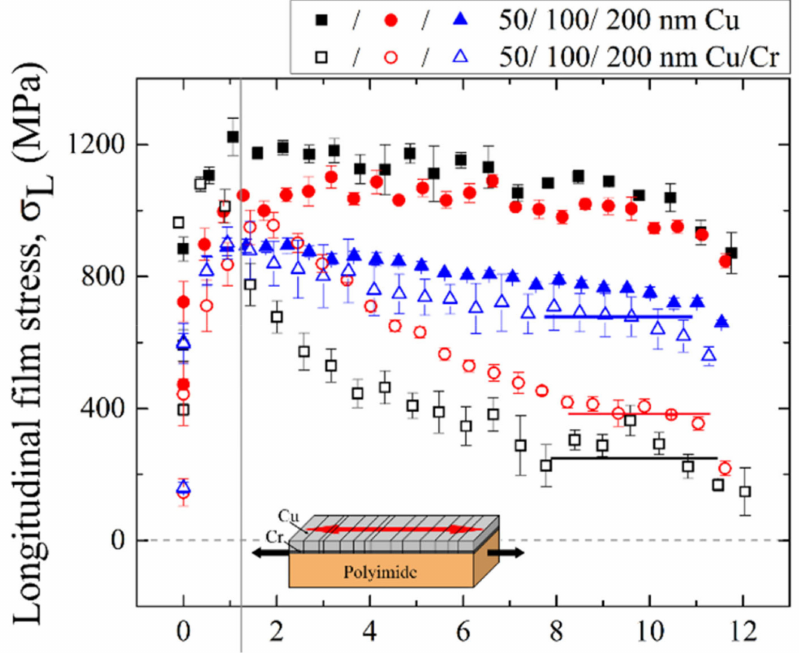
Figure 9. In-situ XRD stress measurements during tensile straining of single layer sputtered Cu films (50, 100, 200 nm, filled symbols) and Cu/Cr bilayers (10 nm Cr interlayers, same Cu thicknesses, open symbols) illustrate that when brittle interlayers are used, the Cu film stresses decrease after reaching a maximum stress due to TTC formation. The single Cu layers continue to have high stresses with further applied strain because TTCs do not form. Figure from [64]. Reprinted from Acta Materilia, Vol. 89, V.M Marx, F. Toth, A. Wiesinger, J. Berger, C. Kirchlechner, M.J. Cordill, F.D. Fischer, F.G. Rammerstorfer, G. Dehm, The influence of a brittle Cr interlayer on the deformation behavior of thin Cu films on flexible substrates: Experiment and model, p. 278–289, (2015) with permission from Elsevier (CC by